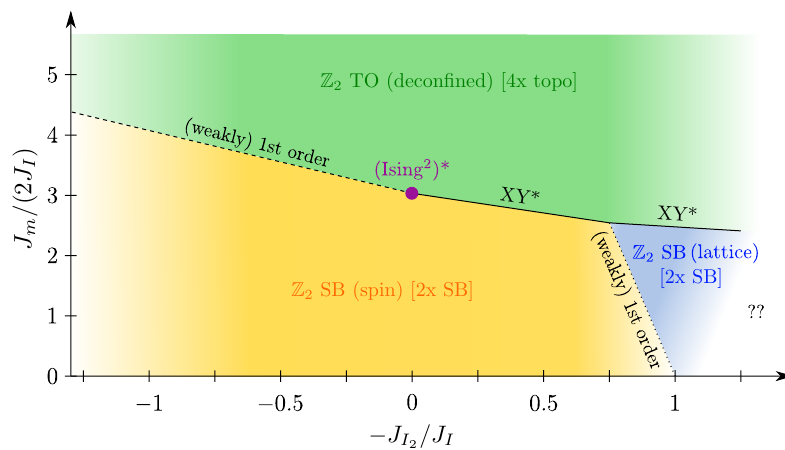
Figure 7: Sketch of the phase diagram for the TCI model, Eq. (1). Full lines de- note continuous phase transitions, dashed lines (weakly) first order transitions. TO denotes topological order, (cid:90) SB denotes states that spontaneously break a (cid:90) sym- 2 2 metry, while (spin) indicates that the spin-inversion symmetry is broken, and (lat- tice) indicates that the sublattice exchange symmetry (part of the larger lattice space symmetry group) is broken. The question marks indicate regions we have not inves- tigated in detail. The ground state degeneracy of the phases (on a torus) is given by the numbers in square brackets, where “topo” (“SB”) indicates that the degeneracy is of topological (symmetry-broken)